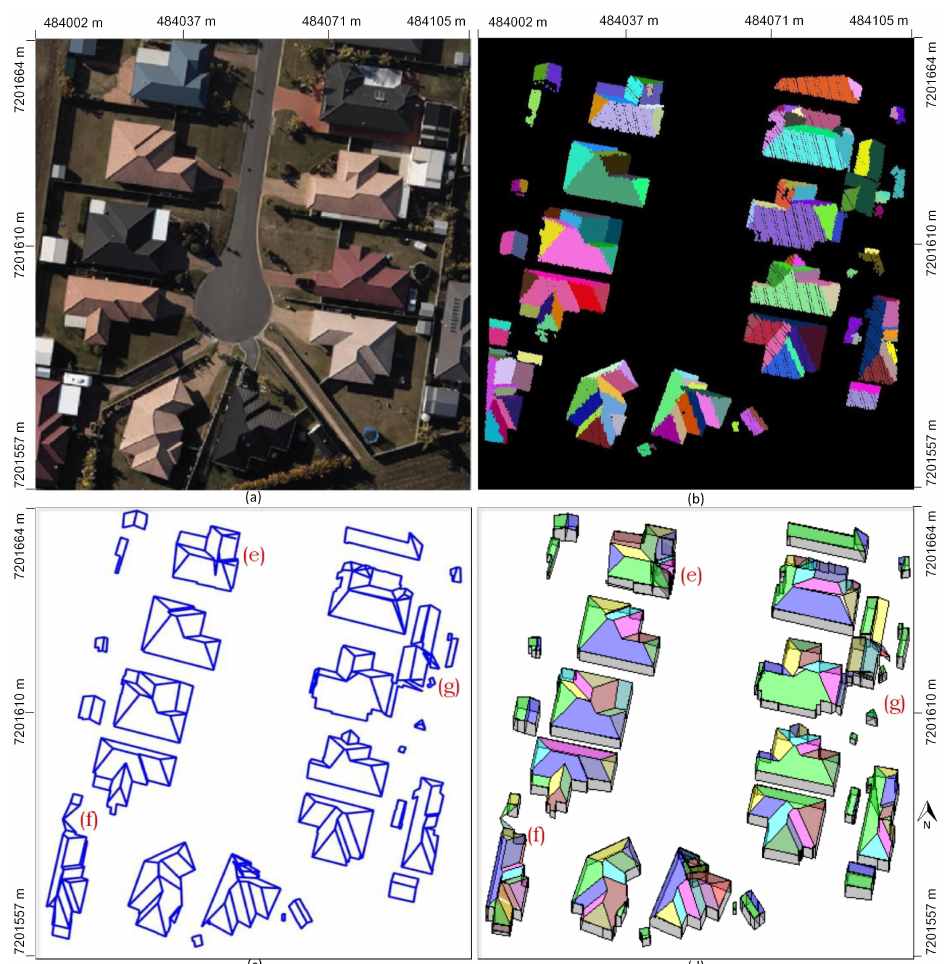
Figure 16. 3-D reconstructed models from Hervey Bay dataset: ( a ) aerial image; ( b ) LiDAR points of input roof planes; ( c ) building roof models; and ( d ) 3-D building